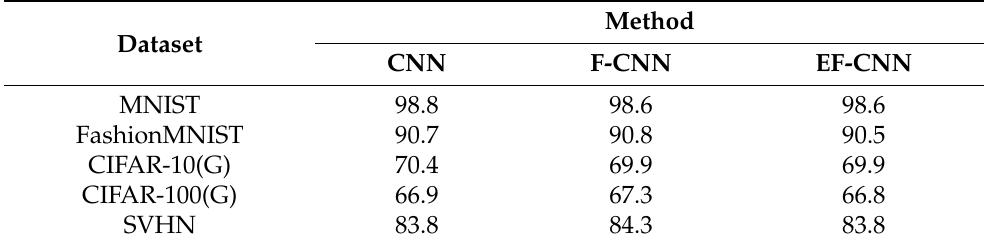
Table 6. Efficient Fourier CNN accuracy (%) of LeNet-3 on gray-scale datasets.